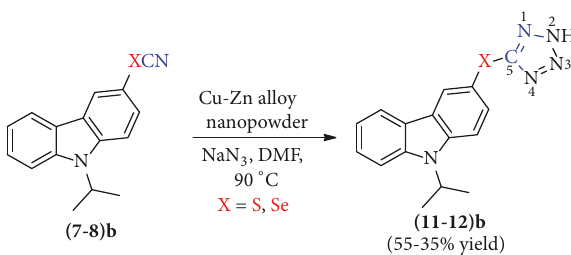
Scheme 2: Cu-Zn alloy-mediated synthesis of tetrazole